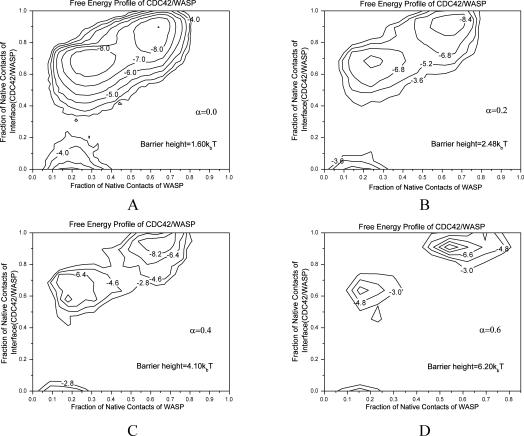
Two-Dimensional Free-Energy Landscape versus Interface Binding of Cdc42 and Folding CBD for Different α